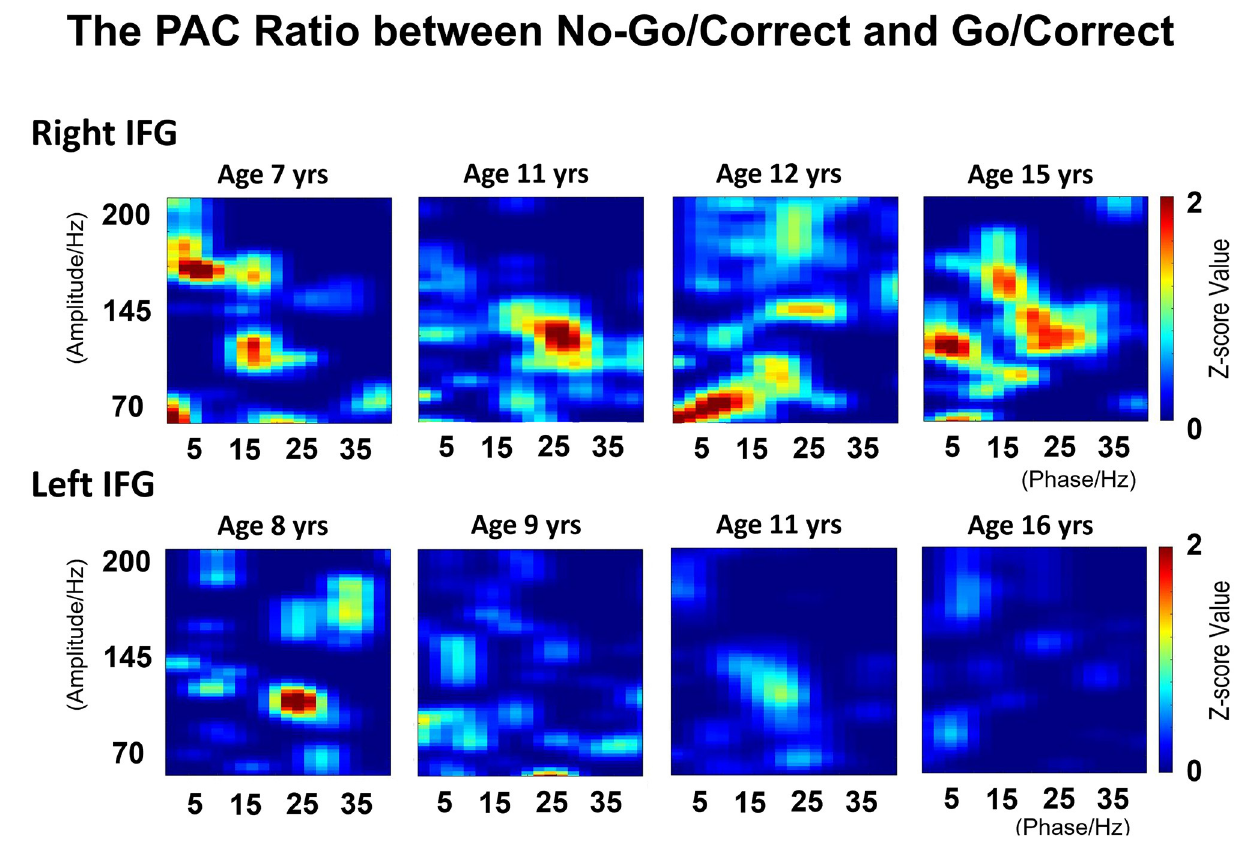
FIGURE 9 | The phase-amplitude coupling (PAC) values were calculated by modulating the index between low-frequency phase (2–40Hz) and high frequency amplitude (70–200Hz) in Go/Correct and No-Go/Correct conditions. The illustration revealed the calculated ratio between Go/Correct and No-Go/Correct conditions in right and left-side IFGs. For the right IFG, the PAC value in No-Go/Correct conditions is higher than that in Go/Correct conditions, which means the ratio is over 1, and consistent between the low-frequency phase (5–25Hz) and high frequency amplitude (100–150Hz). For left IFG, a similar pattern was observed in younger patients, but the ratio decreased with